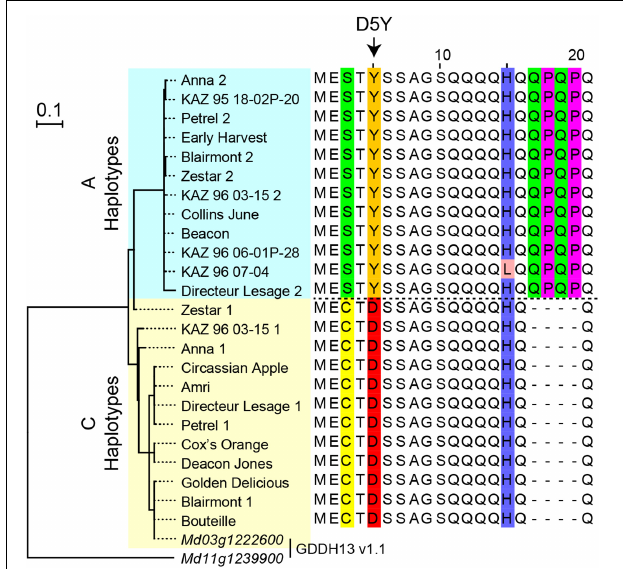
FIGURE 3 | Polymorphisms within the NAC18.1 gene. Maximum likelihood phylogenetic tree of 24 NAC18.1 sequences from 18 apple cultivars and the reference genome (GDDH13 v1.1) sequences of NAC18.1 (Md03g1222600) and its closest homolog (Md11g1239900). Amino acid sequence alignment of the N-terminal region of NAC18.1, illustrating additional variation in the coding sequence in strong LD with the D5Y variant. The complete amino acid sequence alignment is provided in Supplementary Figure 6